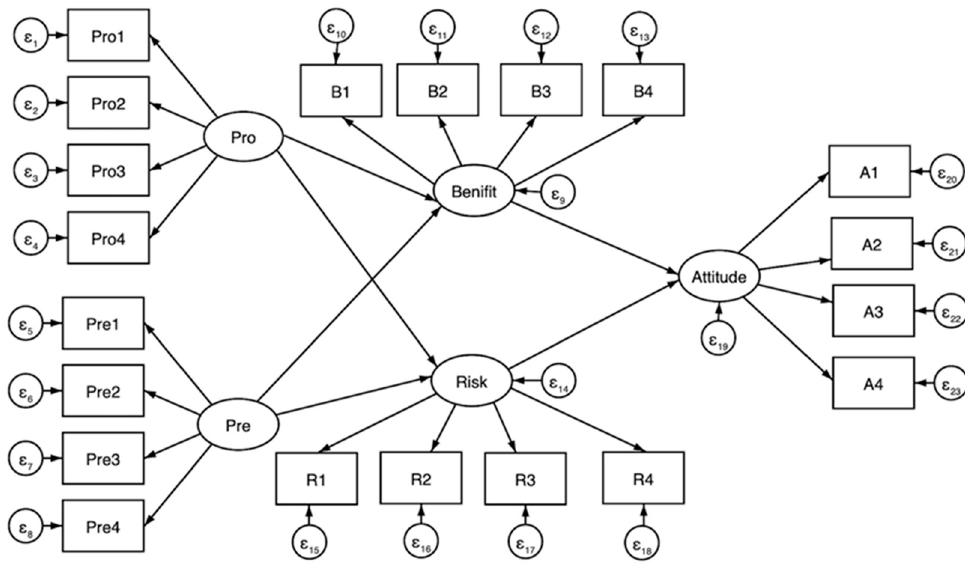
Figure 1. The Structural equation modeling.